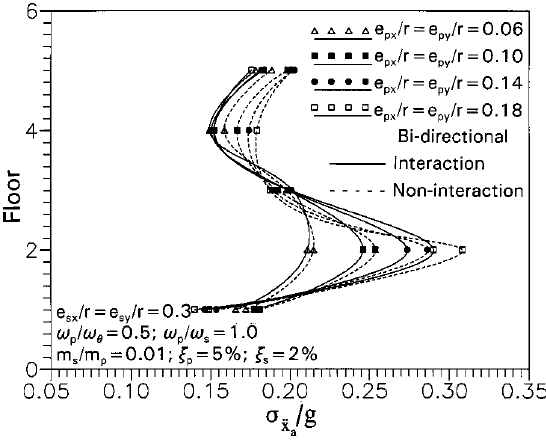
=g with storey height for various values of Fig. 7. Variation of (cid:27) (cid:127) x a e p x =r and e p y =r ; for m s =m p = 0.01; ! p =! s = 1.5; ! p =! (cid:18) = 1.0; e s x =r = e s y =r = 0.3; (cid:24) p = 5% and (cid:24) s =